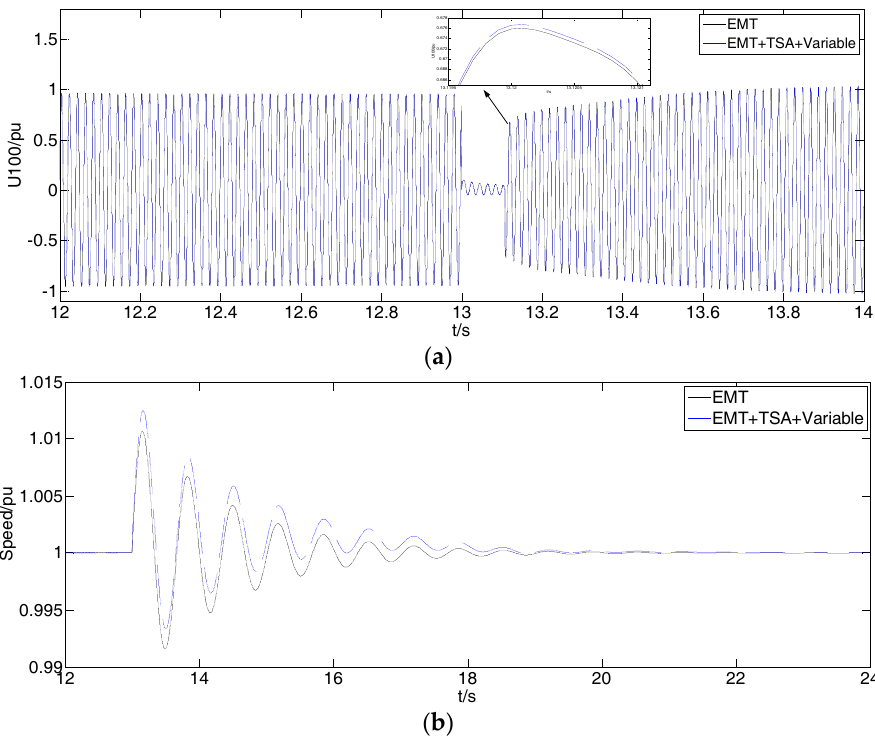
Figure 7. Comparison of simulation accuracy under case two. ( a ) Phase A voltage at bus 100 under case two; and, ( b ) Rotor speed of generator at bus 100 under case two.